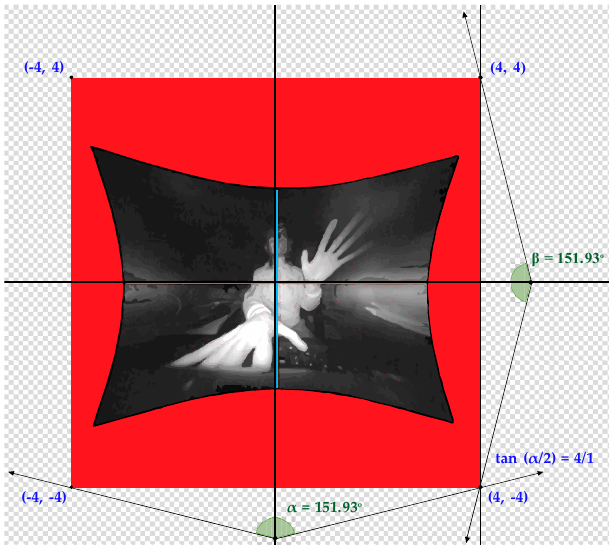
Figure 14. Image with the distortion corrected before reaching the microcontroller.